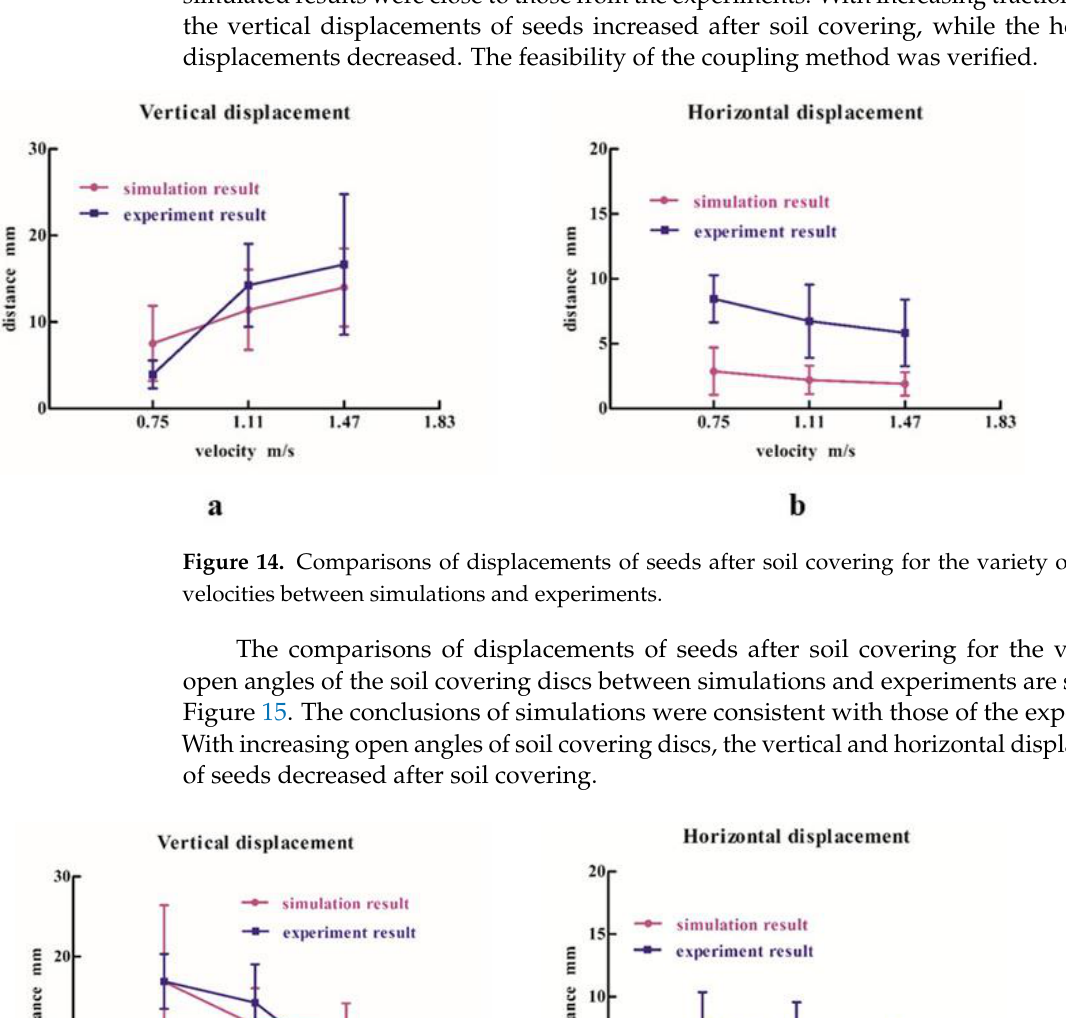
12 of 16 Figure 13. Screenshots of the soil covering simulation. Soil particles obtained larger instantaneous velocities when the contact action be- tween the discs and the soils occurred. This was due to the forward velocity of the ap- paratus and the peripheral speed produced by the rotation of the discs. When the for-